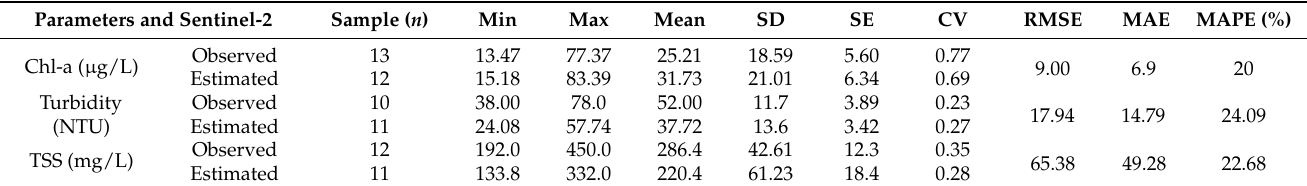
Table 4. Descriptive statistics of the observed (laboratory-measured) and predicted (satellite image- based analysis) water quality